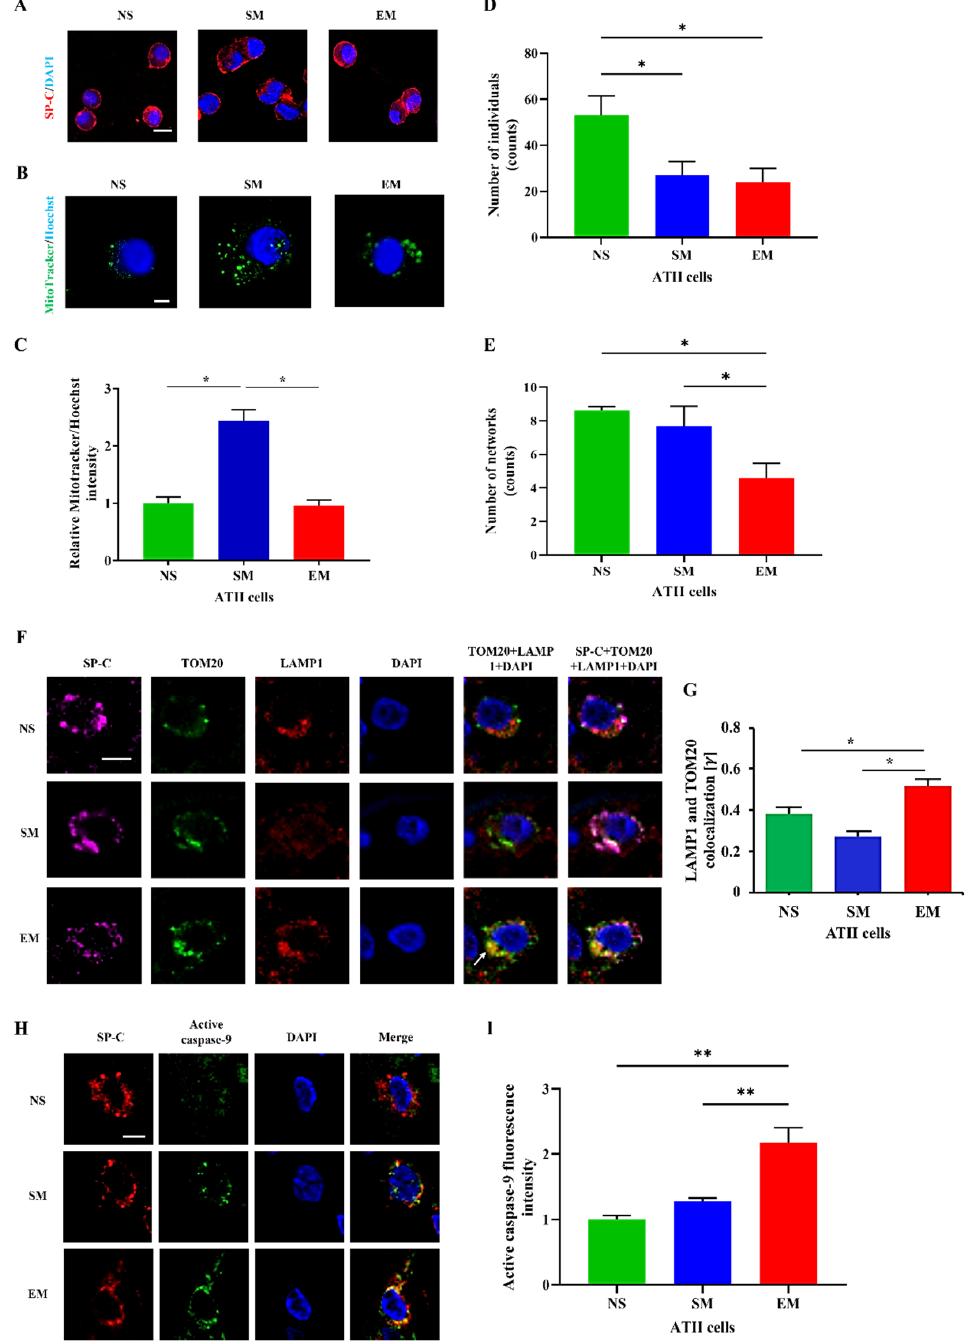
Figure 2. Human primary ATII cell purity and mitochondrial amount. ( A ) ATII cells were isolated from lungs obtained from nonsmokers (NS), smokers (SM), and emphysema patients (EM). Cytospins of freshly isolated ATII cells were stained using SP-C and DAPI (immunofluorescence; scale bar, 10 µ m). ( B ) Mitochondrial amount was determined using MitoTracker dye and a confocal flu- orescence microscope (scale bar, 5 μ m). ( C ) Quantification is also shown. The number of individuals ( D ) and networks ( E ) of mitochondrial structures were quantified using MitoTracker staining. ( F ) Co-localization of mitochondrial protein TOM20 (green) with LAMP1 (red) in ATII cells using